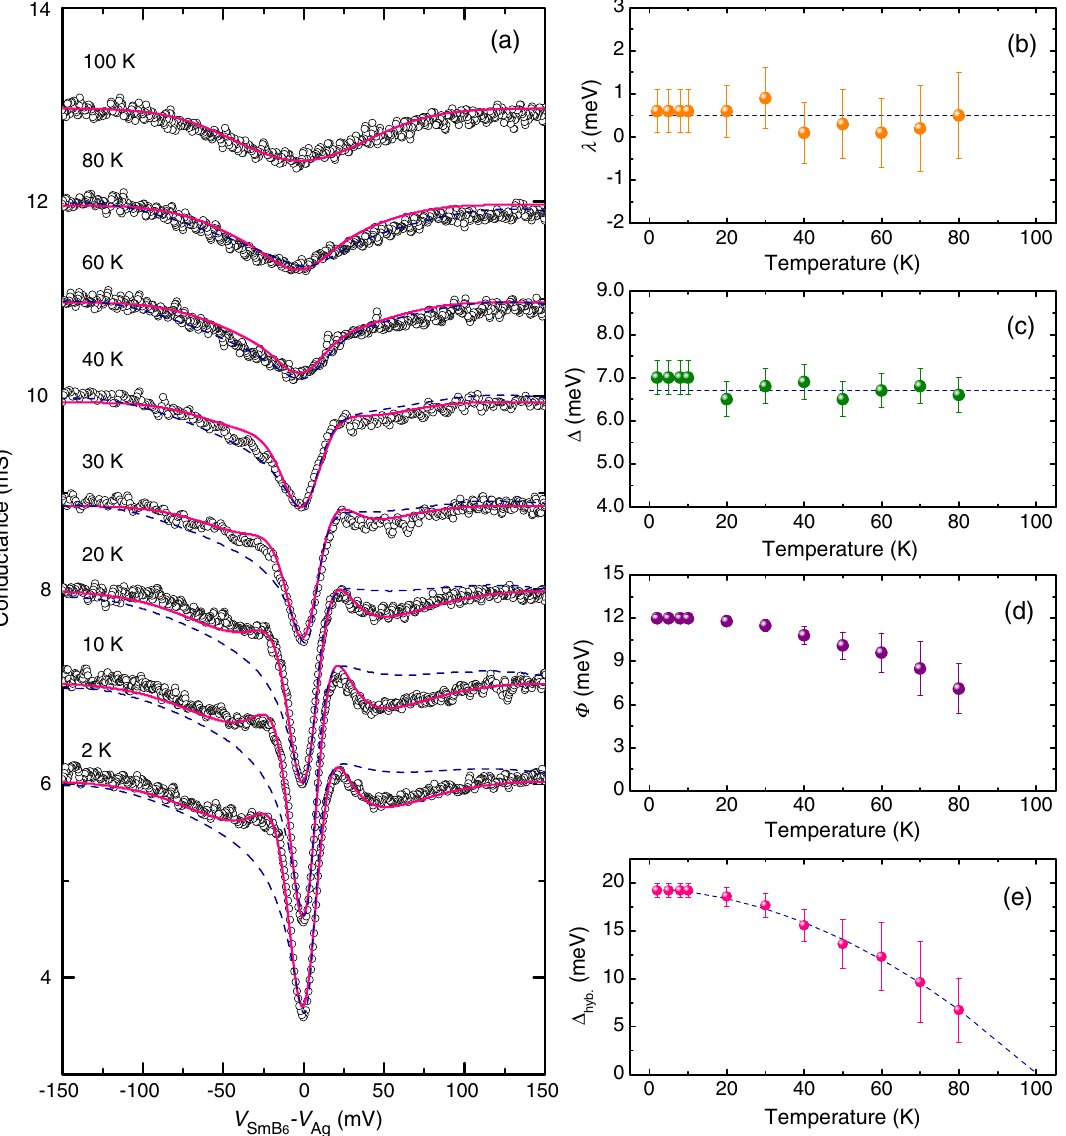
FIG. 2. (a) The observed conductance spectra with the best fits to the classical Fano-resonance line shape [Eq. (1) and dashed lines] and to the tunneling model for Kondo lattices [Eq. (2) and solid lines], respectively. For clarity, only the spectrum and the simulations for 2 K are plotted with the actual value, while other curves are vertically shifted. (b), (c), and (d) show the temperature dependence of (cid:2) (renormalized f level), (cid:1) (Kondo resonance width), and (cid:2) (half of the direct gap size), respectively, used in the Kondo-lattice- tunneling simulations. The dashed line in (b) and (c) suggests that both the renormalized f level and the Kondo gap width are nearly temperature independent in the entire temperature range below 100 K. (e) The temperature dependence of the hybridization gap extracted from the hybridization amplitude and the bandwidth D , based on the Kondo-lattice-tunneling model. The dashed line in (e) represents a smooth trend of the size of the hybridization gap as the temperature changes. The extrapolation of the curve suggests that the hybridization gap vanishes at a temperature of around 100